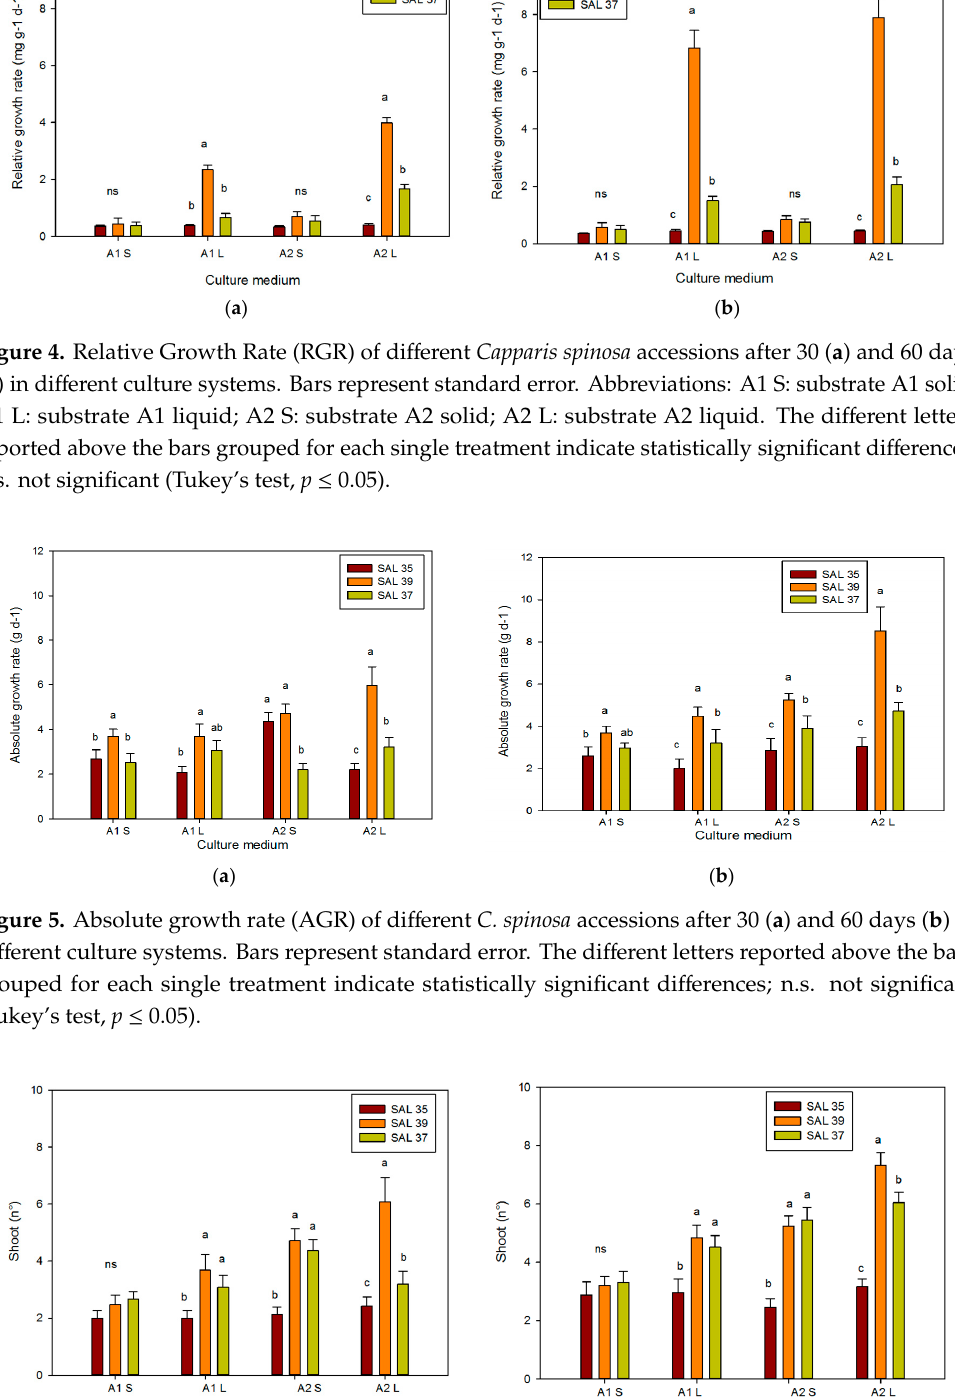
( b ) Figure 3. Explants of caper accessions “ Sal 37” ( a ) and “Sal 39” ( b ) in solid substrate after 60 days . The selection “Sal 39” showed the best RGR results (3.98 mg g − 1 d − 1 ) in the substrate containing mT after 30 days in the TIS; on the other hand, with the solid medium, an RGR equal to 0.69 mg g − 1 d − 1 was obtained. On the contrary, the “Sal 35” selection showed a reduced adaption to all of the different culture systems, showing the lowest RGR (Figure 4). The RGR, calculated at 30 and 60 days, showed an improvement of culture growth in the TIS compared to the solid system. Similar results